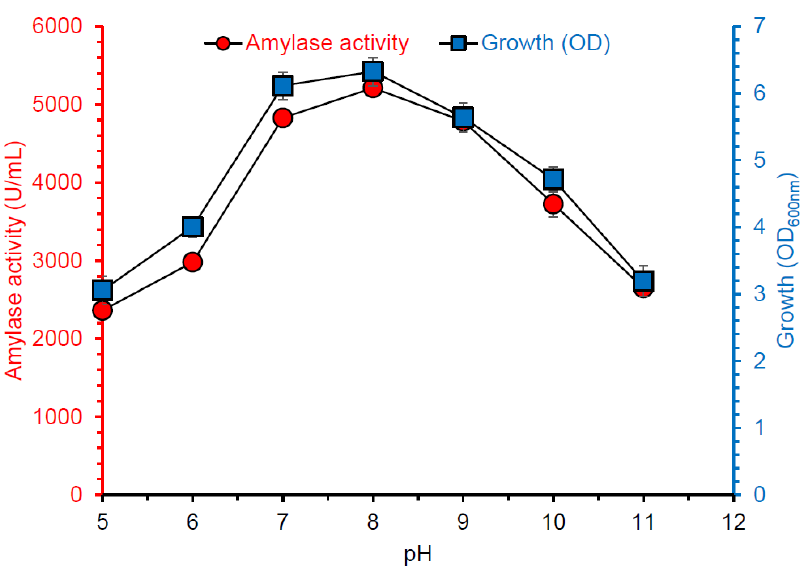
Figure 5. The effect of the initial pH on amylase production and microbial growth ( Bacillus sp. BCC 021-50) at 50 °C for 36 h in a mineral medium containing molasses (20 g/L) and peptone (10 g/L) as carbon and nitrogen sources, respectively. The experiments were performed in triplicate and the data presented in the figure are the average of three parallel experiments. Error bars are shown for standard deviation.